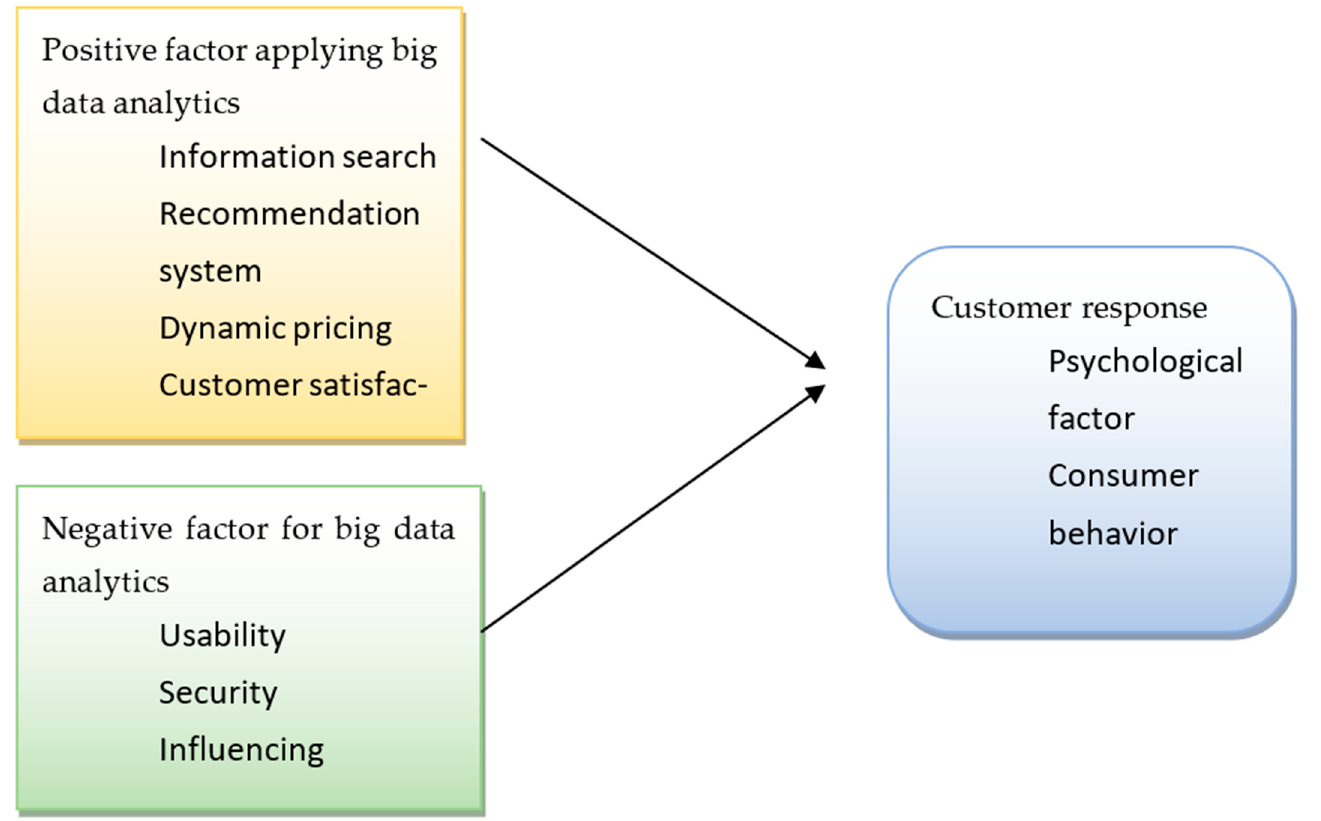
Figure 5. Proposed